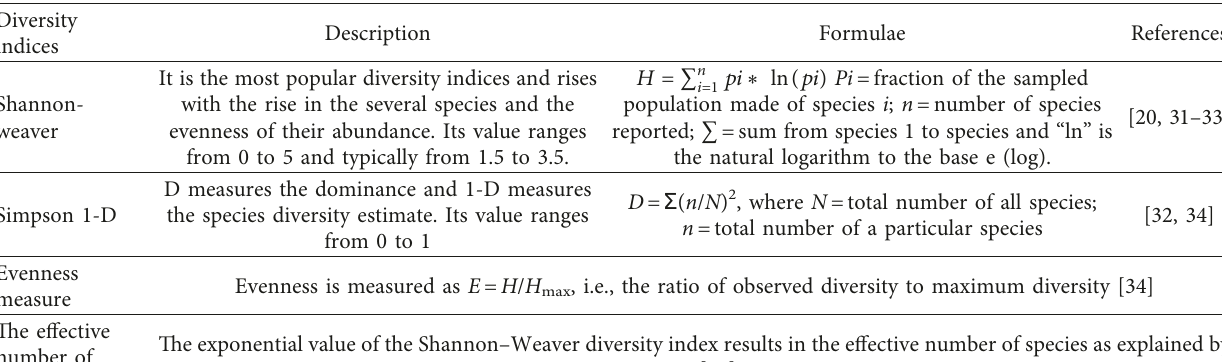
Table 3: Details of the diversity indices used for analysis.